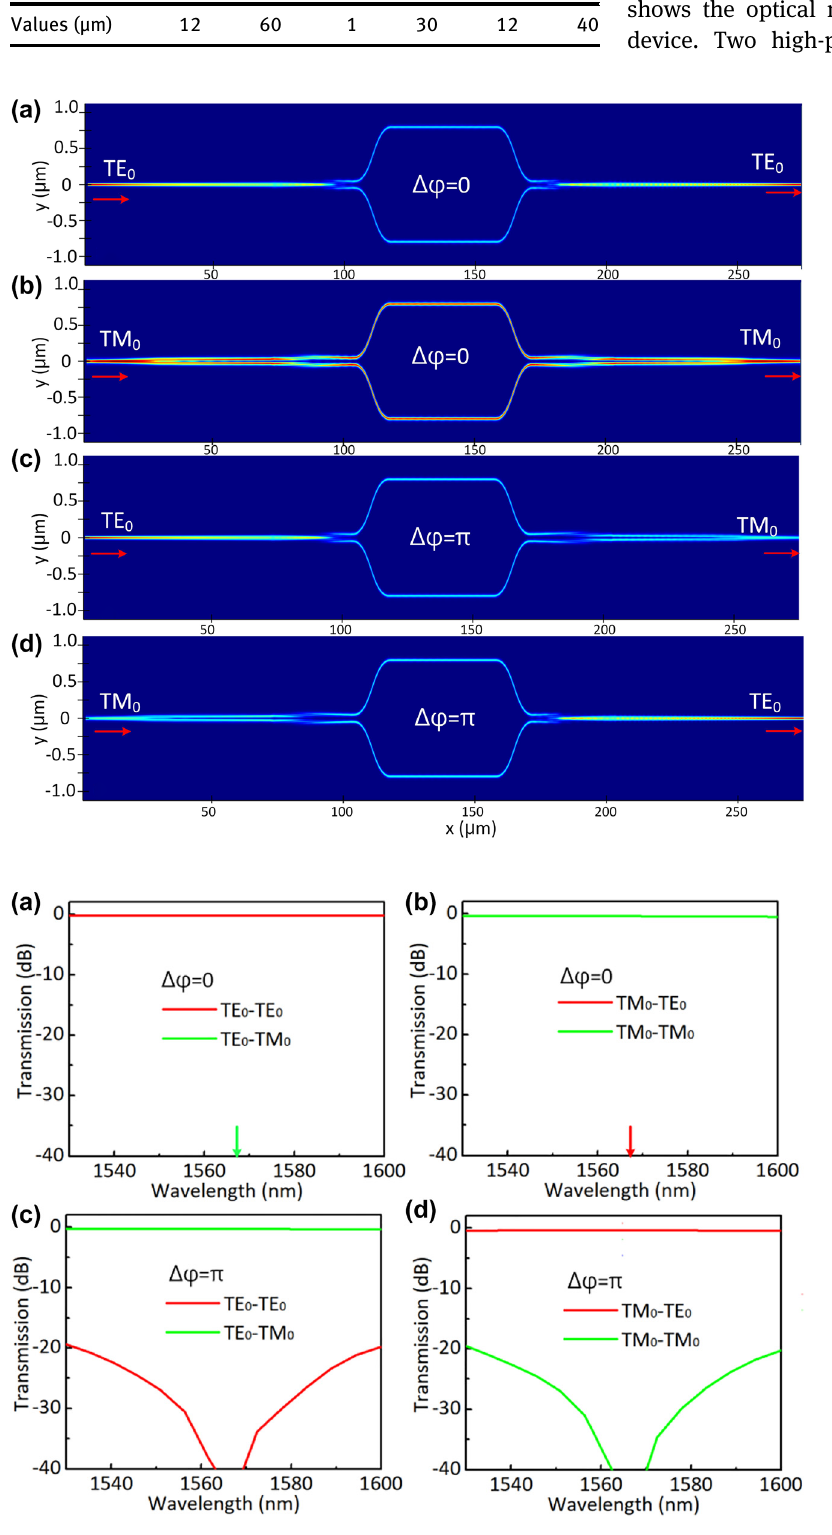
Figure 8: Simulated light transmissions of the designed polarization switch for the launched TE 0 (a) and TM 0 (b) modes with Δ φ = 0; simulated light propagation of the designed polarization switch for the launched TE 0 (c) and TM 0 (d) modes with Δ φ = π